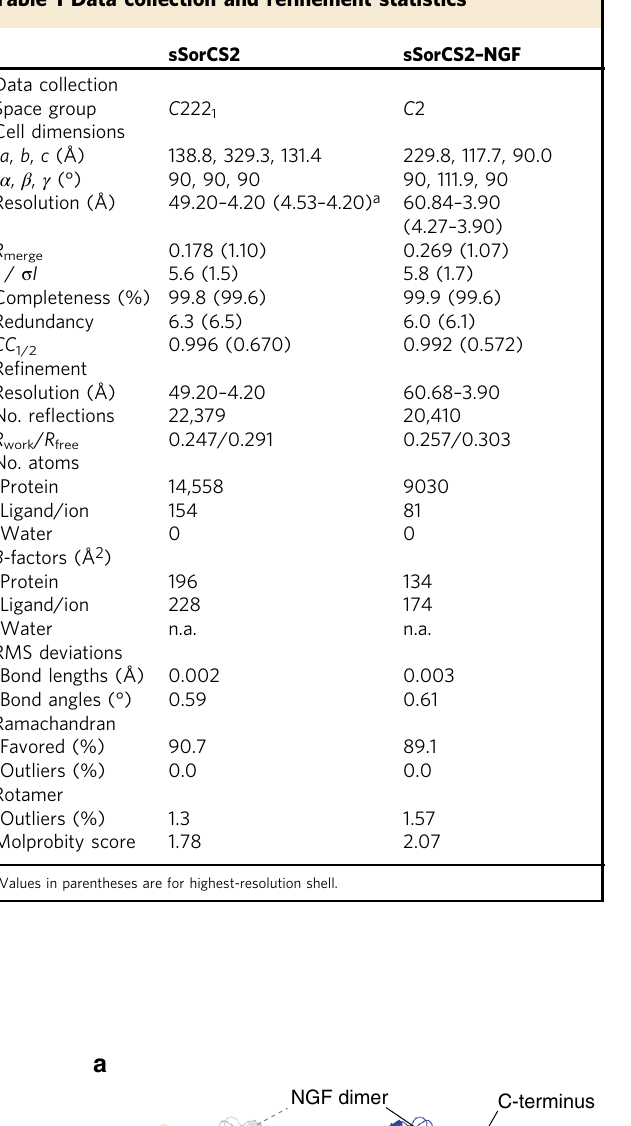
Table 1 Data collection and re fi nement statistics